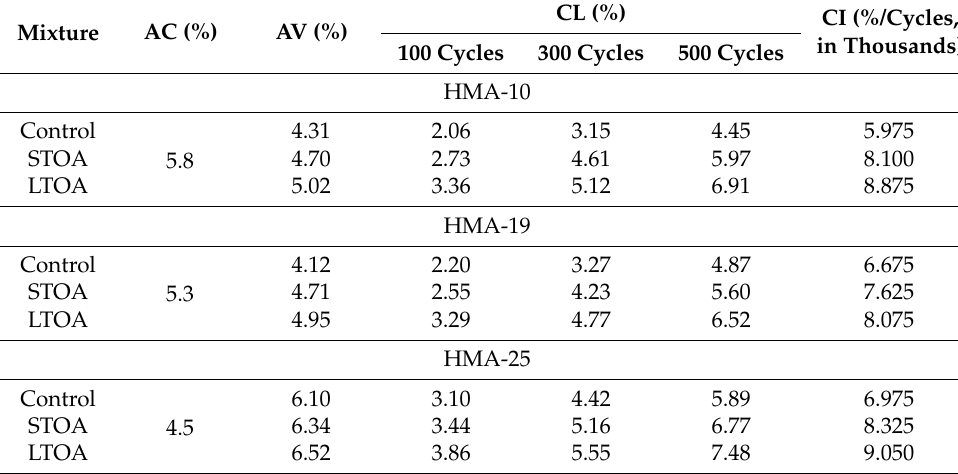
Table 5. Cantabro test